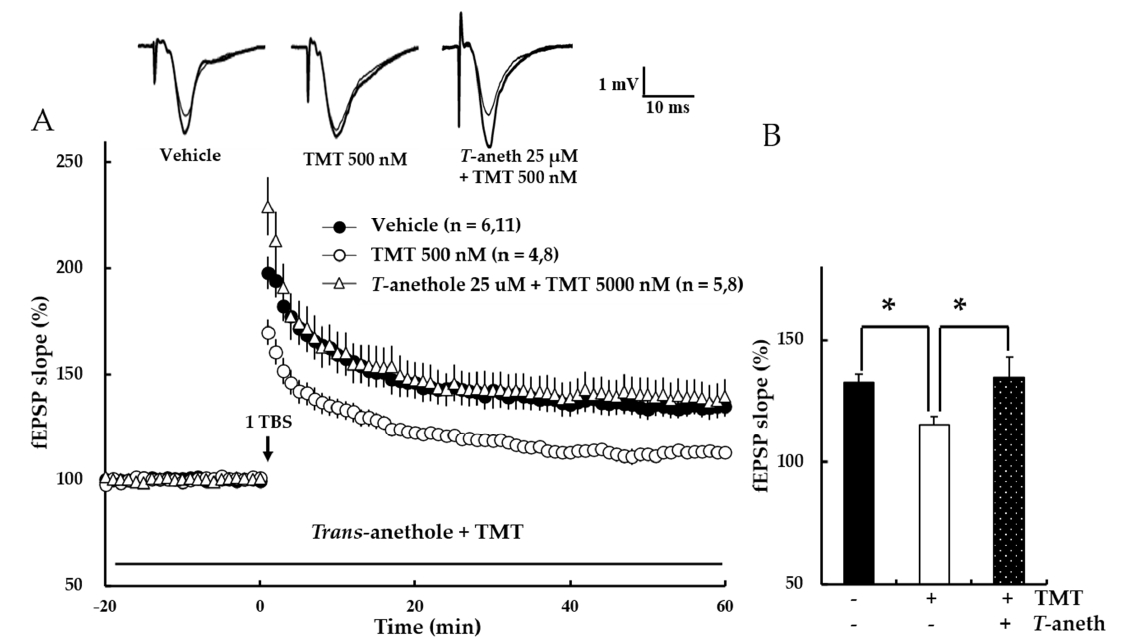
Figure 8. Trans ‐ anethole (25 μ M) attenuates TMT ‐ induced impairment in NMDA receptor ‐ dependent LTP. ( A ) The responses represent LTP induction over 1 h after NMDA receptor ‐ dependent LTP was induced by 1 TBS. Trans ‐ anethole (25 μ M) was applied 10 min before the addition of TMT (500 nM), which was perfused in aCSF during the time period indicated by the bar. The numbers of mice and slices, respectively, are shown in parentheses. Filled circles, open circles, and open triangles indicate the Vehicle group, 500 nM TMT group, and 25 μ M Trans ‐ anethole + 500 nM TMT group, respectively. ( B ) Values represent percent changes in the EPSP slope observed at 58–60 min. Statistical significance (* p < 0.05 vs. 500 nM TMT) was calculated by one ‐ way ANOVA followed by Tukey HSD test. T ‐ aneth: Trans ‐ anethole; fEPSP: field excitatory synaptic potential.